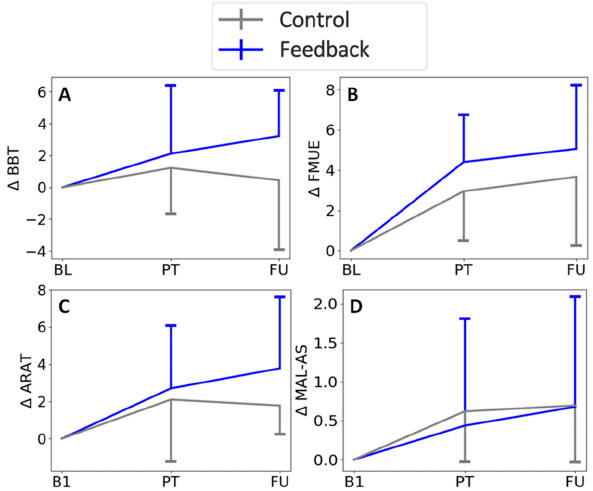
Figure 7. Change in clinical scores from baseline. For BBT and FMUE, B1 is the average for the scores from the two baseline assessments. Bars represent 1 standard deviation. Time points are BL = baseline, B1 = baseline 1, PT = post-therapy, FU = Follow-up. Clinical assessments are BBT = Box and Blocks Test, FMUE = Fugl-Meyer Upper Extremity Scale, ARAT = Action Research Arm Test, MAL-AS = Motor Activity Log—Amount Scale. GroupXtime interactions were not significant.